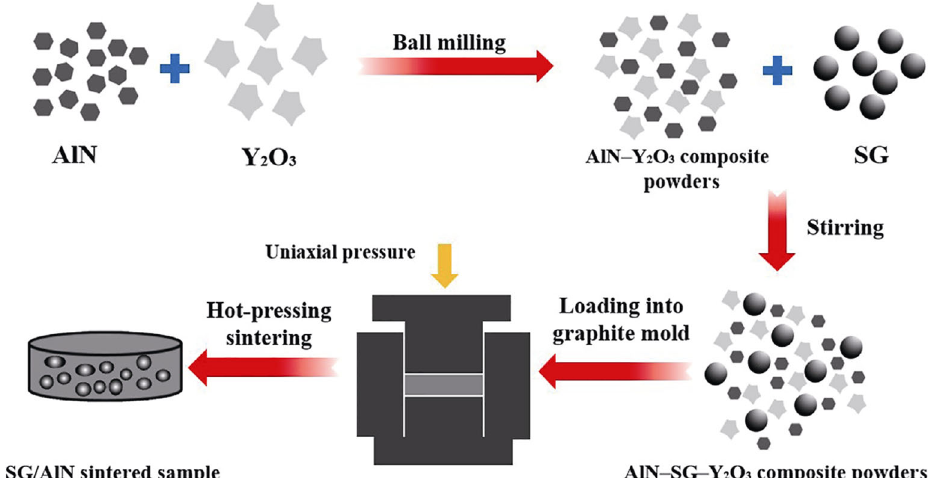
Fig. 2 Schematic of the preparation process for fabricating the SG/AlN